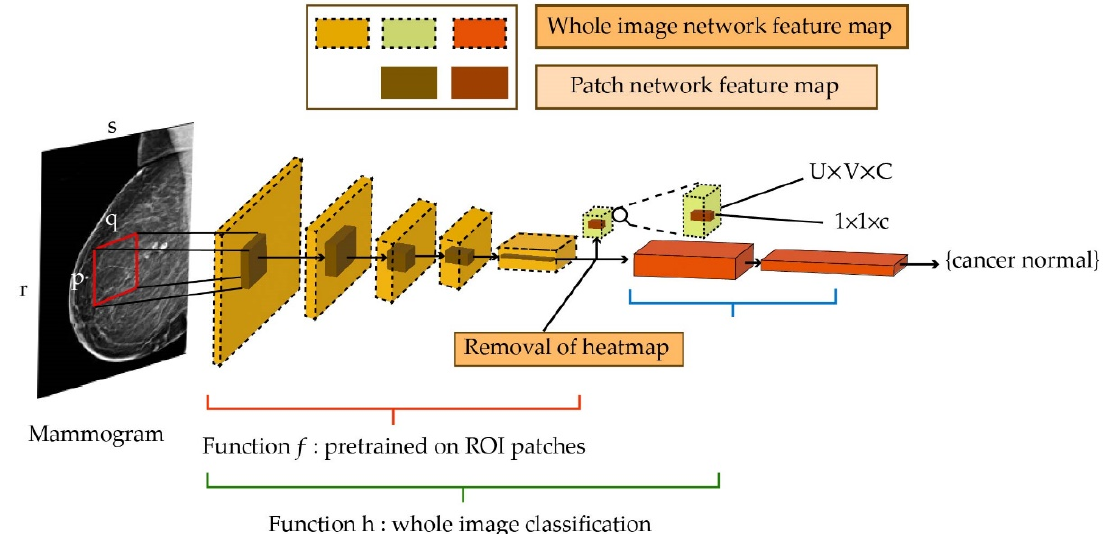
Figure 4. Whole image classification and prediction of cancer or normal.